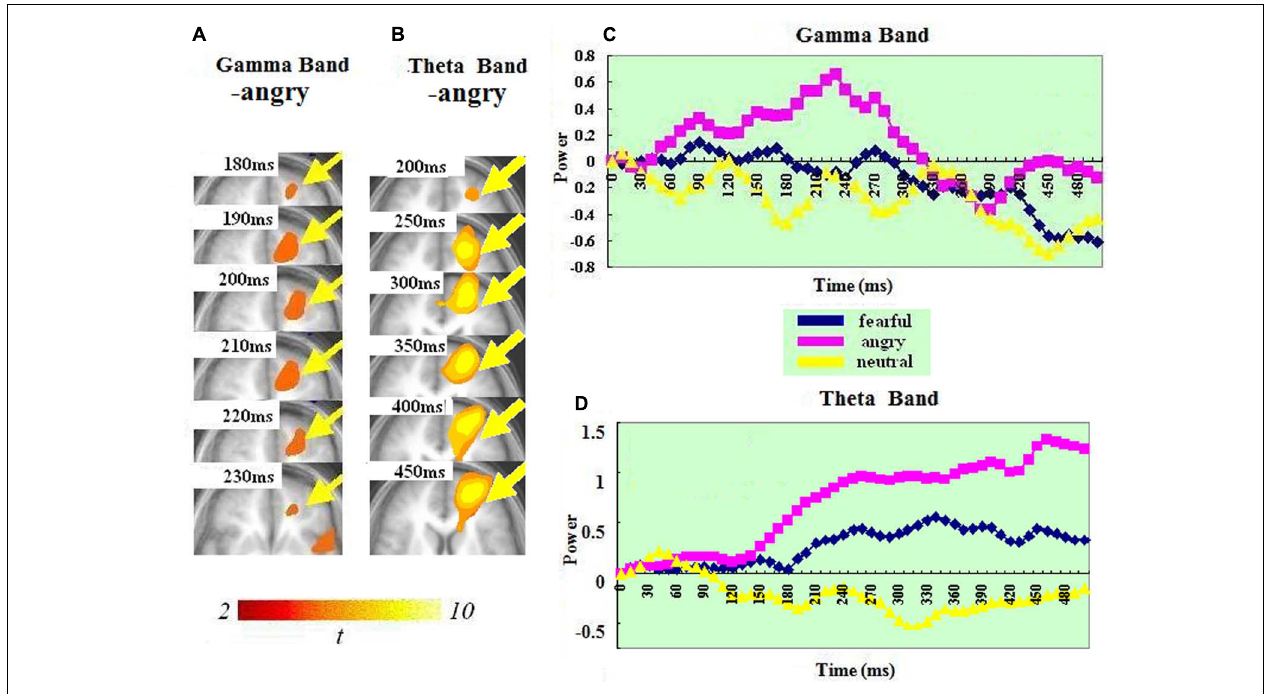
FIGURE 4 | Spatiotemporal profiles for OFC–ACC in the gamma and theta bands. The brain map series (A,B) indicate the ERS development in specific brain areas with the left hemisphere is on the right and the right hemisphere is on the left. The curves (C,D) represent temporal profiles obtained from a peak voxel in a specified area in the three conditions respectively. The time courses are obtained